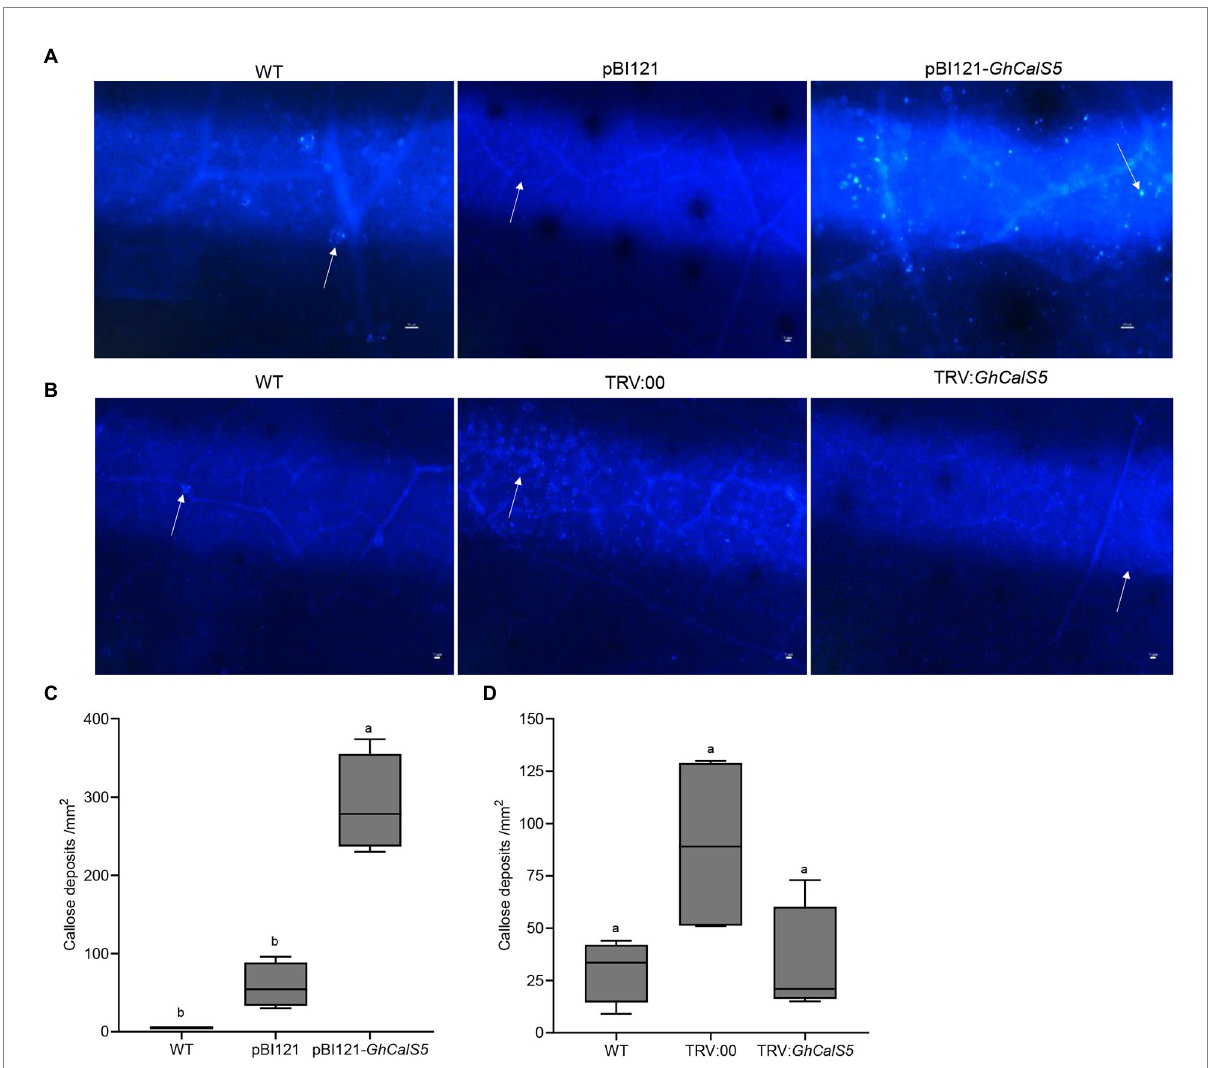
FIGURE 5 Callose deposition and quantification in GhCalS5- overexpressed or silenced cotton leaves. (A) Callose deposition in cotton leaves in WT, pBI121 (control), GhCalS5 -overexpressed. (B) Callose deposition in cotton leaves in TRV: 00 and GhCalS5 -silenced plants. (B) Callose deposits quantification in WT, pBI121 (control), and GhCalS5 -overexpressed using ImageJ software. Callose deposits quantification in (C) WT, pBI121 (control), pBI121-GhCalS5 plants (D) WT, TRV: 00 (control), TRV:GhCalS5 plants using ImageJ software. One-way ANOVA analyzed data. Error bars represents the SD of three biological replicates. Different letters indicate significant differences ( p < 0.05) based on Tukey’s HSD test. Values are shown per mm 2 from the leaf of four independent plants. Scar bar: 50 μ